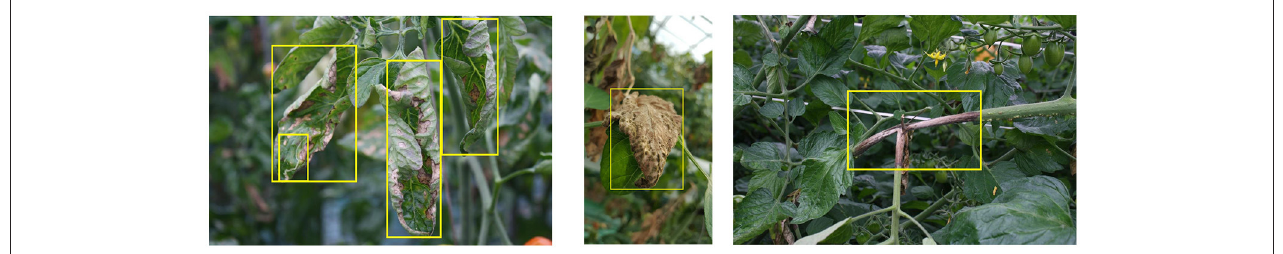
FIGURE 11 | A representation of various images with bounding boxes used for training. The yellow boxes represents the suspicious infected areas of the plant.